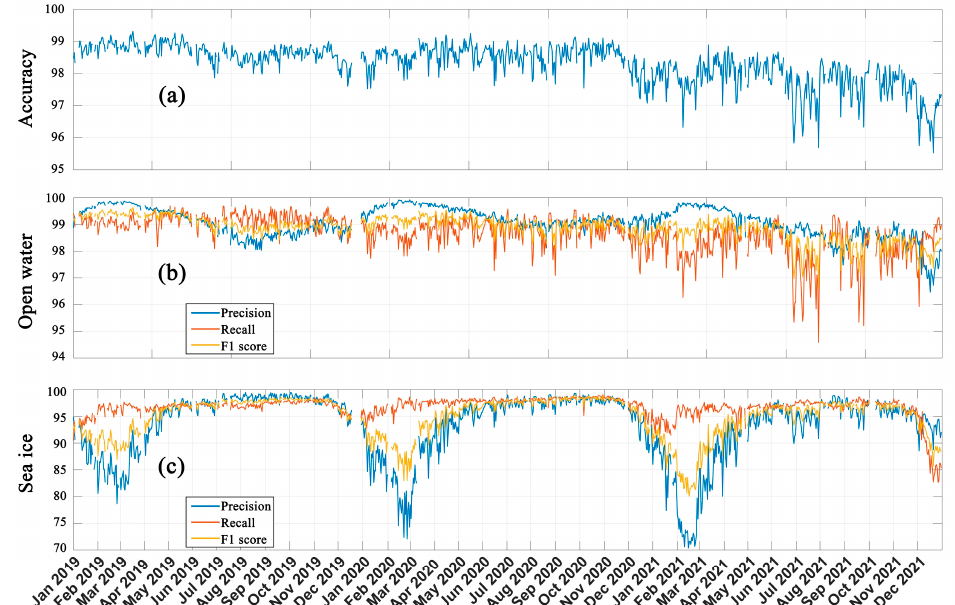
Figure 6. Time series of model performance in the Antarctic for the period from 2019 to 2021: ( a ) overall accuracy; and precision, recall and F1 scores for ( b ) open water and ( c ) sea ice.